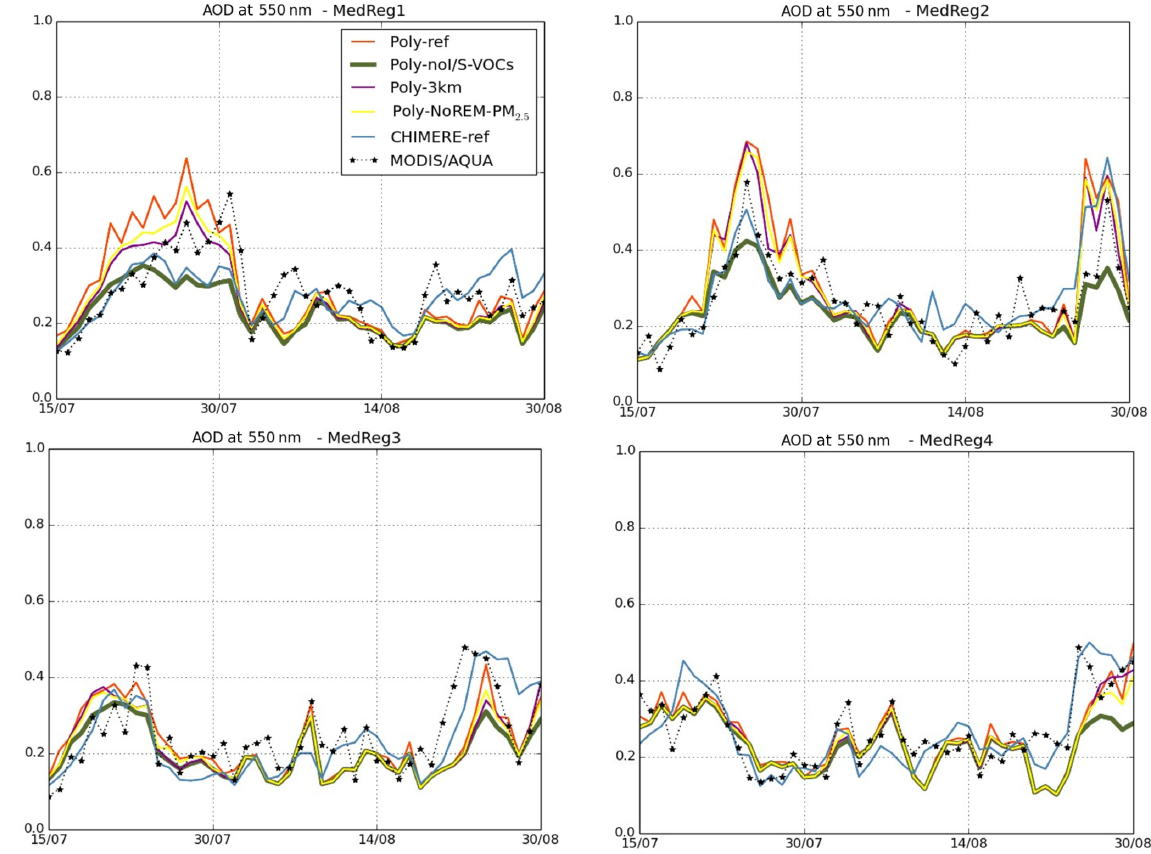
Figure 8. Daily mean AOD at 550nm observed by MODIS and simulated by Polyphemus and CHIMERE from 15 July to 30 August 2007, in the sub-regions of Fig. 1.